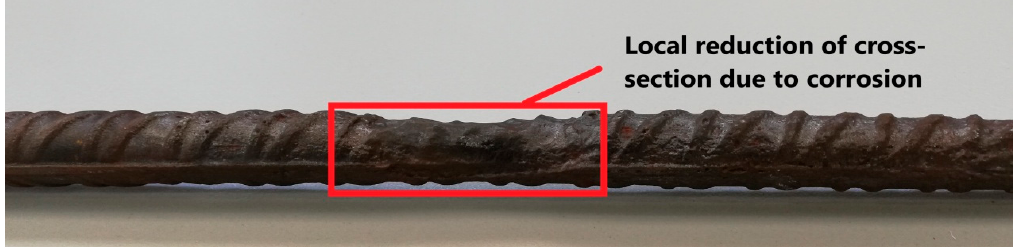
Figure 8. Significant local cross-sectional reduction in reinforcing steel bar due to corrosion.